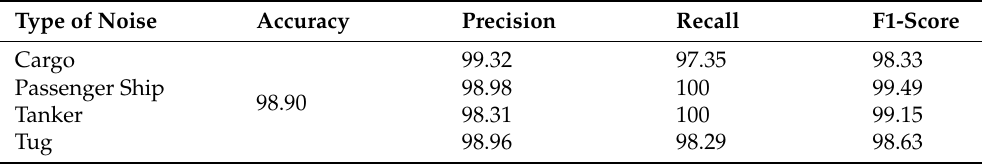
Table 7. Recognition accuracy (%) of combination A with the new